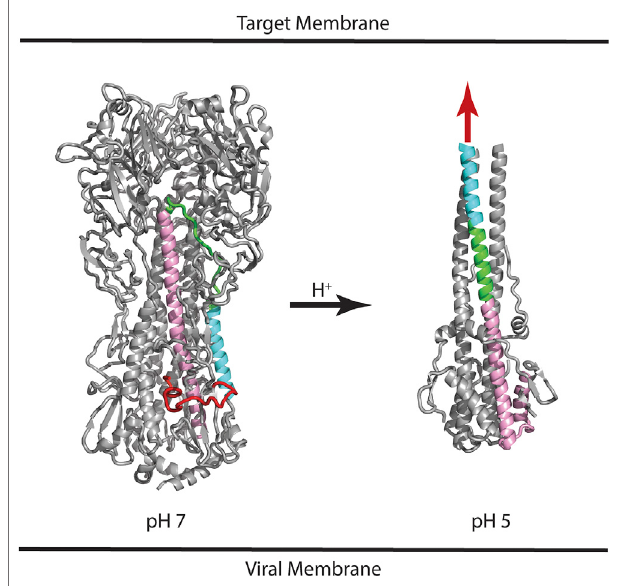
FIGURE 1 | Structures of in fl uenza HA at neutral and low pH. Based on thepresenceoftheC-terminaltransmembranedomain,thevirusmembraneis at the bottom of the panel. Based on the location of the receptor binding domain, the target membrane is located at the top of the panel. Coloring scheme: Fusion peptide (HA2 residues 1 – 21), red; N-helix (HA2 residues 37 – 57), cyan; Stem loop (HA2 residues 58 – 74), green; C-helix (HA2 residues 75 – 126), pink. In the case of the lowpH structure, the HA1 subunit and fusion peptide of HA2 are missing from the construct; the purported location of the fusion peptide is shown as a red arrow. For simplicity, only one of the three subunitsiscolored. PDB fi lescorrespond to2FK0 and1HTMforthepH7and pH 5 structures,